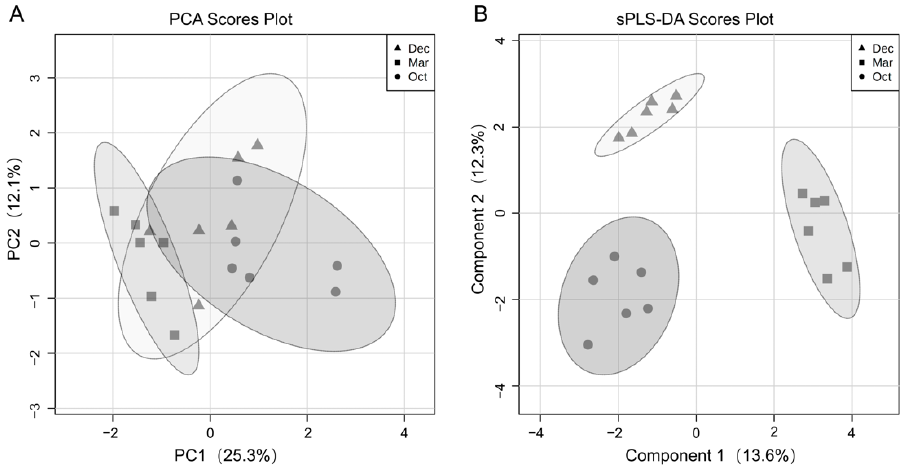
Figure 2. ( A ) Principal component analysis (PCA) and ( B ) sparse partial least squares-discriminant analysis (sPLS-DA) of serum metabolites in grazing yaks during the cold season. A total of 17 differential metabolites were obtained in the serum samples based on the VIP obtained from orthogonal PLS-DA (VIP > 1) and the FDR from the student’s t -test (FDR < 0.05, Table 3). Of them, 5 (Oct vs. Dec), 9 (Oct vs. Mar), and 12 (Dec vs. Mar) dif- ferential metabolites were identified in the serum of yaks during the cold season, respec- tively. Compared with December, yaks in October had greater serum concentrations of lyxose (FDR = 0.019), threitol (FDR = 0.027), tyrosine (FDR = 0.027), leucrose (FDR = 0.035), and lower threonic acid (FDR = 0.019). Compared with March, yaks in October had greater serum threitol (FDR = 0.003) and lactic acid (FDR = 0.048), while they had lower serum monostearin (FDR < 0.001), 1-monopalmitin (FDR < 0.001), threonic acid (FDR < 0.001), D- (glycerol 1-phosphate) (FDR = 0.001), arachidonic acid (FDR = 0.004), glycine (FDR = 0.027), and gluconic acid (FDR = 0.033). All 12 differential metabolites of yak serum were lower in December compared with March, including monostearin (FDR < 0.001), 1-mono- palmitin (FDR < 0.001), D-(glycerol 1-phosphate) (FDR < 0.001), arachidonic acid (FDR < 0.001), α-ketoglutaric acid (FDR = 0.011), gluconic acid (FDR = 0.012), serine (FDR = 0.019), glycine (FDR = 0.019), phosphate (FDR = 0.023), 3-hydroxybenzoic acid (FDR = 0.033), glu- curonic acid (FDR = 0.034), and threonic acid (FDR = 0.047). Table 3. Differential serum metabolites in yaks grazing in different months of the cold season. Metabolite Name